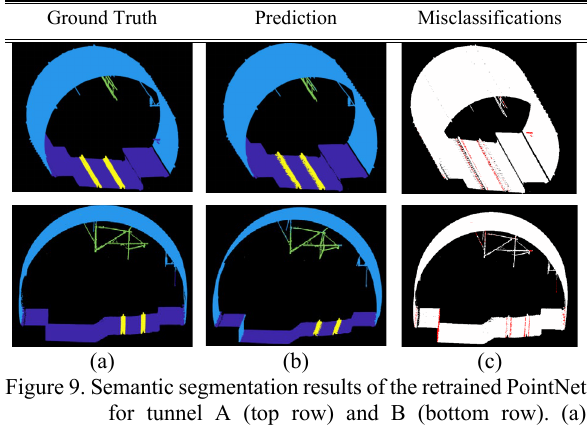
Figure 9. Semantic segmentation results of the retrained PointNet for tunnel A (top row) and B (bottom row). (a) Ground truth. (b) Prediction. (c) Misclassified points (in red).